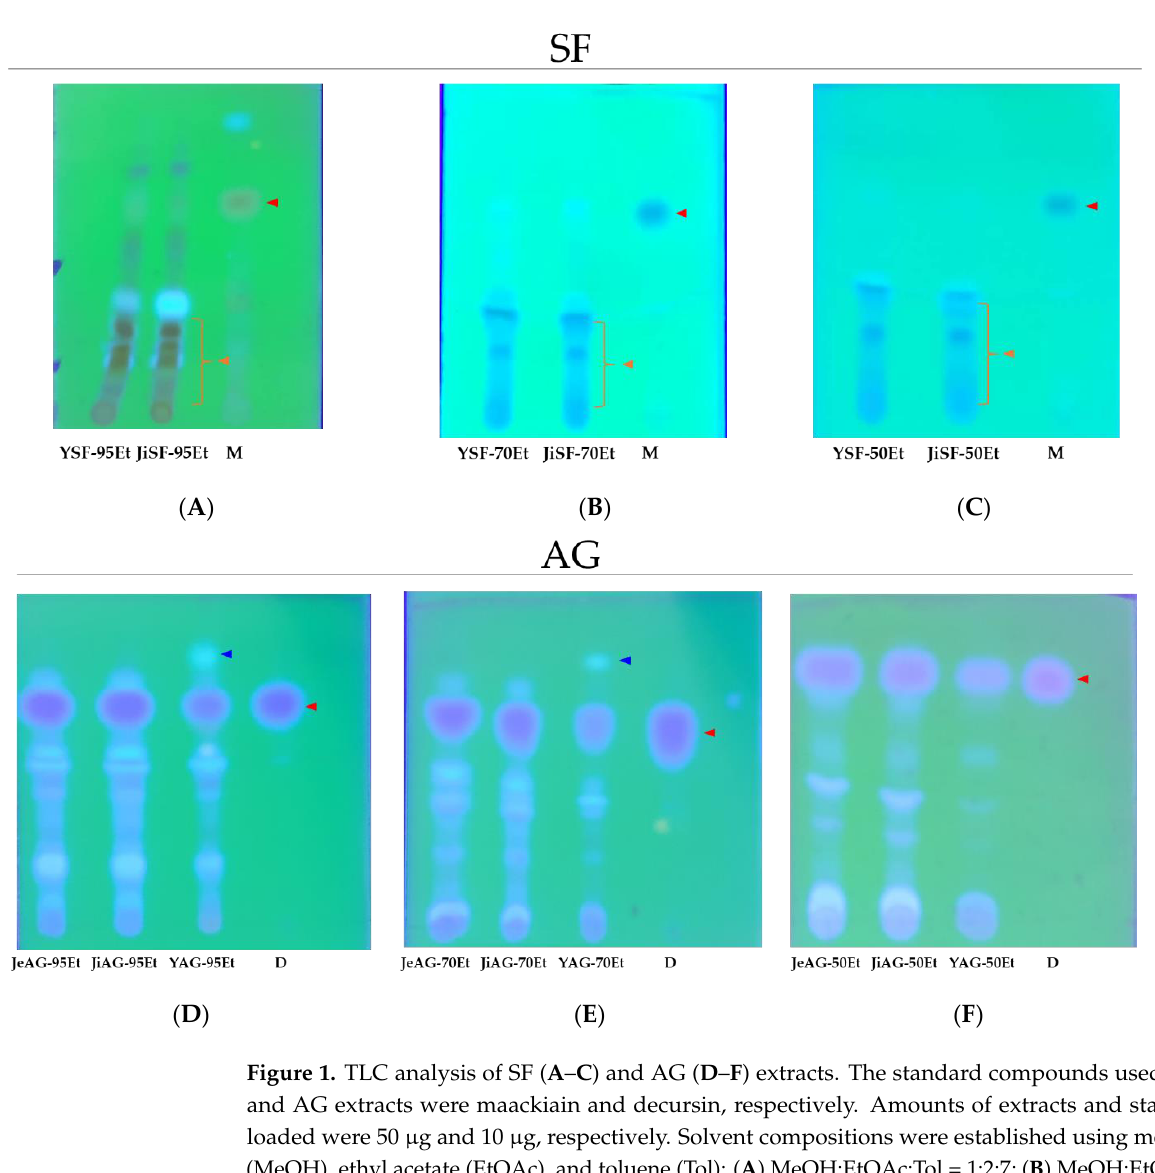
(MeOH), ethyl acetate (EtOAc), and toluene (Tol): ( A ) MeOH:EtOAc:Tol = 1:2:7; ( B ) MeOH:EtOAc:Tol MeOH:EtOAc:Tol = 1:1:8; ( C ) MeOH:EtOAc:Tol = 1:1:8; ( D ) MeOH:EtOAc:Tol = 2:1:7; ( E )